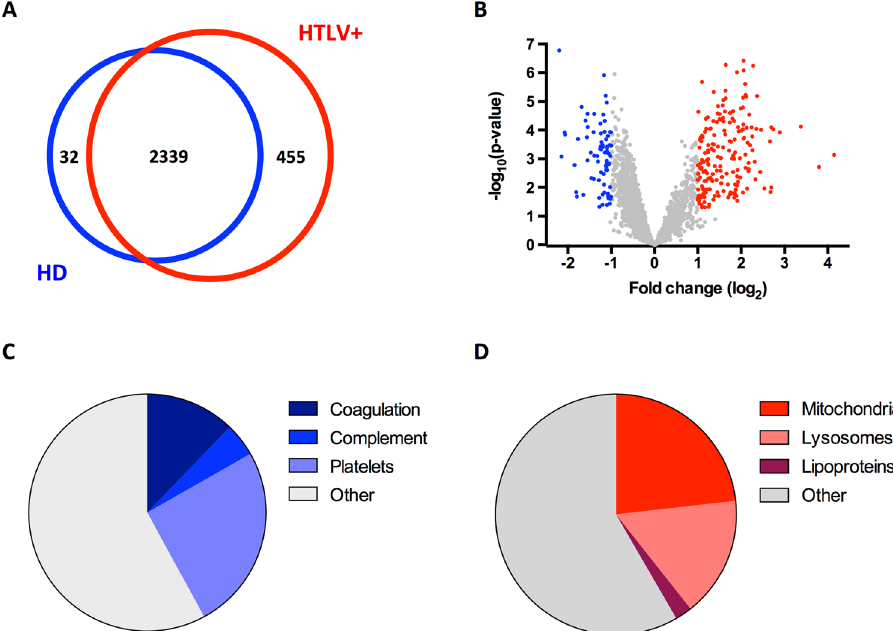
Figure 3. Alterations in protein composition of EVs upon HTLV-1 infection. ( A ) Venn diagram showing the overlap of proteins identified in EVs from NI and HTLV-1 infected individuals. ( B ) Volcano plot representing the quantitative analysis of protein composition of EV from NI and HTLV-1 infected donors. Blue and red dots correspond to proteins more abundant in EVs from HD and HTLV-1 infected individuals, respectively. ( C ) Functional analysis of proteins enriched in EVs from NI. The list of enriched proteins was analyzed with FUNRICH and STRING softwares. The pie chart represents the proportion of proteins associated with coagulation, complement, or the other proteins composing platelet granules. ( D ) Functional analysis of proteins enriched in EVs from HTLV-1 infected donors. The pie chart represents the proportion of proteins present in lipoproteins, lysosomes or